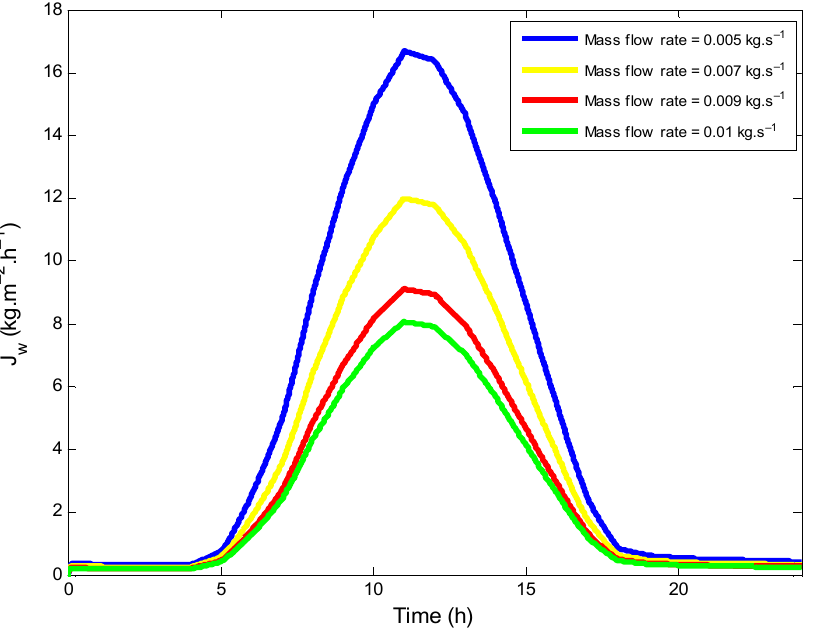
Figure 13. Variation of permeate flux of the different flow rates over the local time. Air gap thickness is an important key. It plays a major role in the AGMD performance because the air gap is another additional resistance for the mass transfer to the AGMD process [13,14]. Figure 14 shows the effect of air gap thickness on permeate flow in intervals ranging from 1 to 3 mm. The influence of the air gap thickness was studied at a constant feed concentration of groundwater of 3.5 g · L − 1 , while the flow rates of feed and coolant were kept constant at 2 L · min − 1 . The increased air gap thickness in the module at